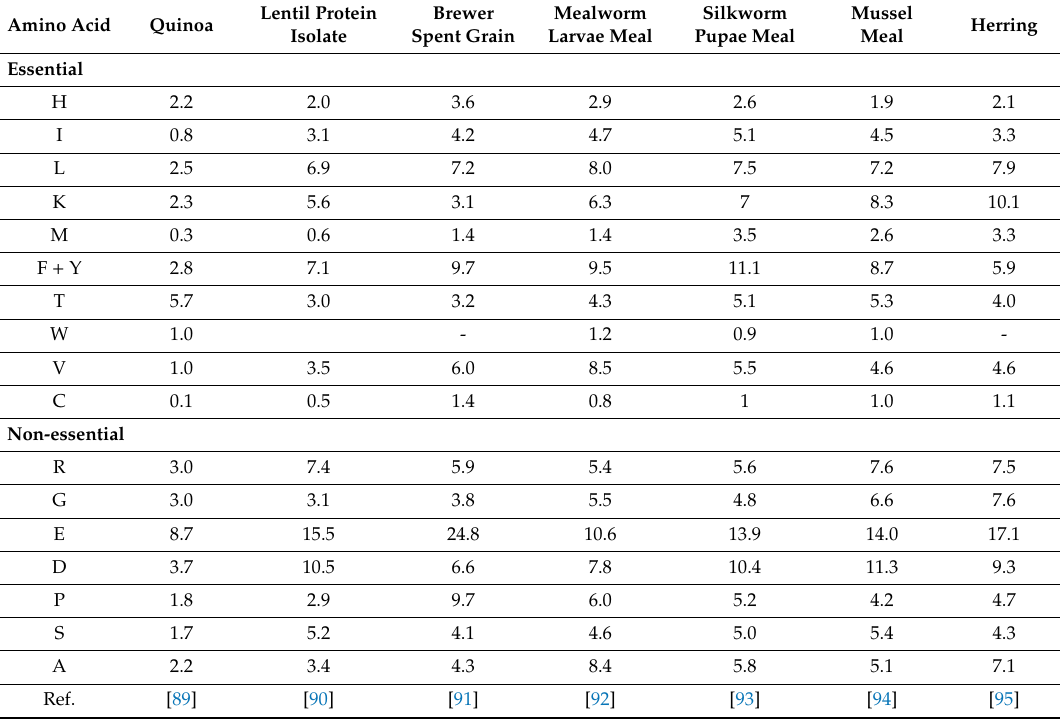
Table 1. Amino acid content of some vegetable, insect and fish proteins (g / 100 g of substrate). Lentil Protein Brewer Mealworm Silkworm Mussel Quinoa Isolate Spent Grain Larvae Meal Pupae Meal Meal